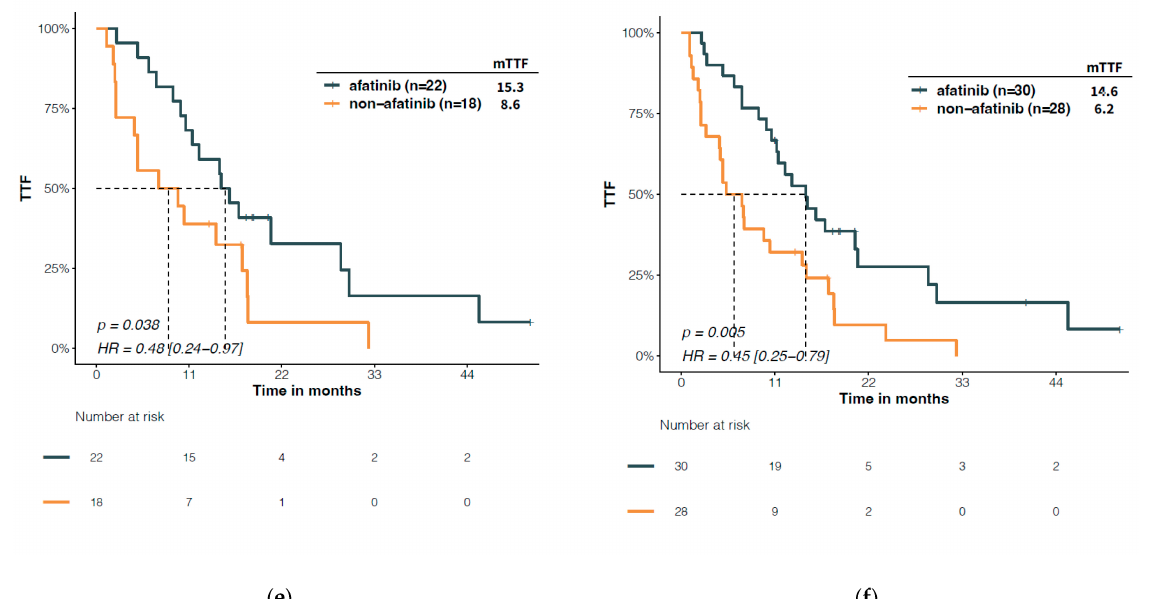
Figure 5. Differential time to treatment failure (TTF) in patients with PACC EGFR mutations with different treatments. ( a , b ) Comparison among the EGFR TKI, chemotherapy, and immune checkpoint inhibitor (ICI). ( c , d ) Comparison among 1st, 2nd, and 3rd gen EGFR TKIs. ( e , f ) Comparison between afatinib and other EGFR TKIs. Non-afatinib treatment includes osimertinib (n = 4), erlotinib (n = 1), gefitinib (n = 4), and icotinib (n = 9) for 1st line, and osimertinib (n = 9), erlotinib (n = 3), gefitinib (n = 5), icotinib (n = 9), ametinib (n = 1), and dacomitinib (n = 1) for all lines.